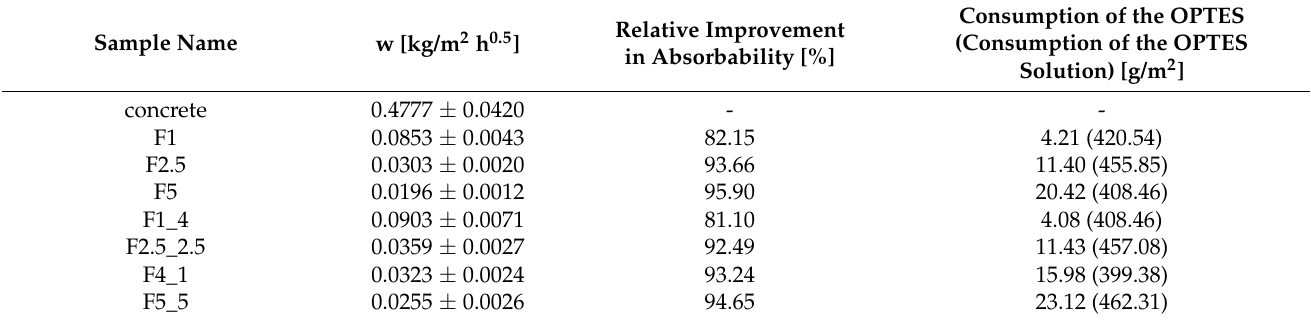
Table 3. Relative water permeability (w) after 24 h of the immersion of concrete samples without and with silane treatment.